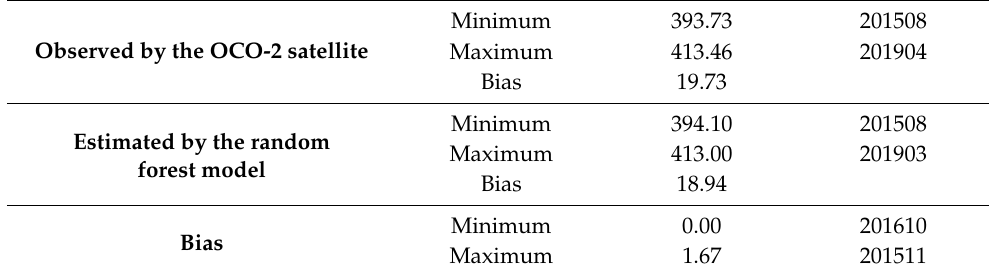
Table 5. The monthly mean concentration changes observed by the satellite and estimated by the model. Observed by the OCO-2